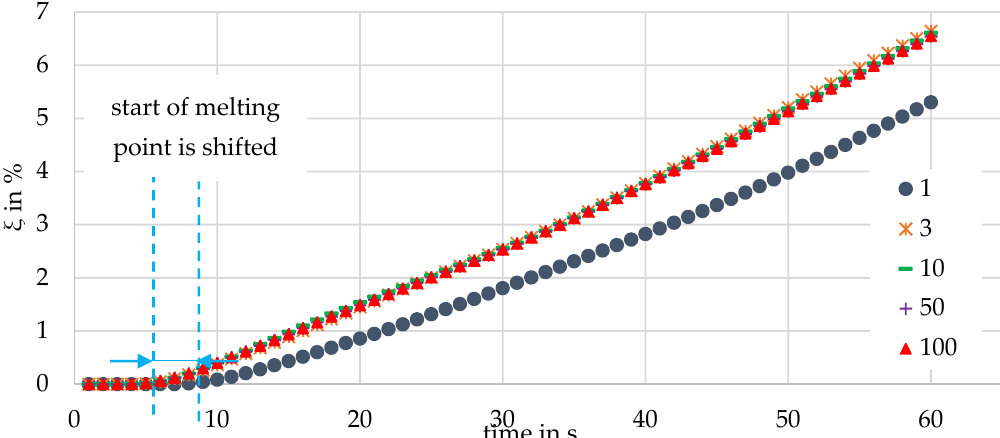
Figure 5. Percentage of molten mass as a function of the number of shells applied over time (stamp force = 100 N, rotational speed = 0 min − 1 ).